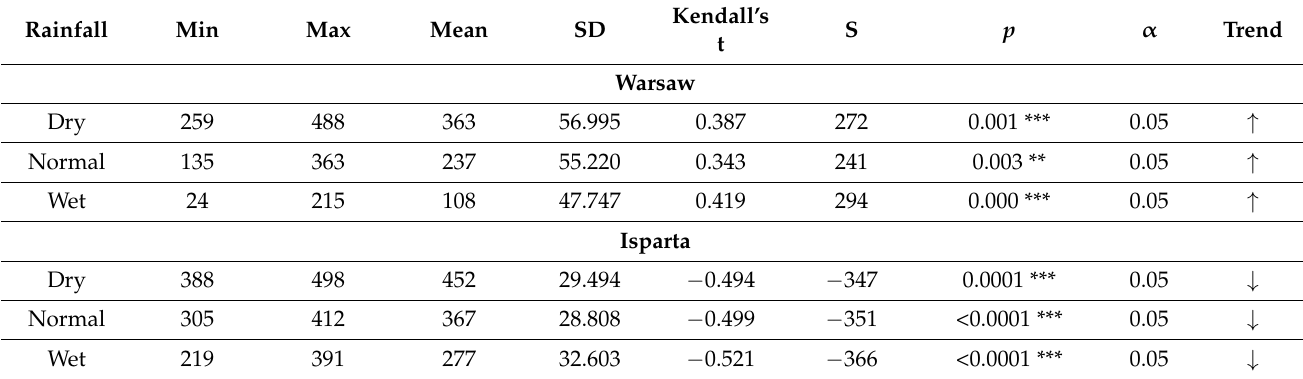
Table 5. Trend changes of crop water requirements according to the dry, normal and wet